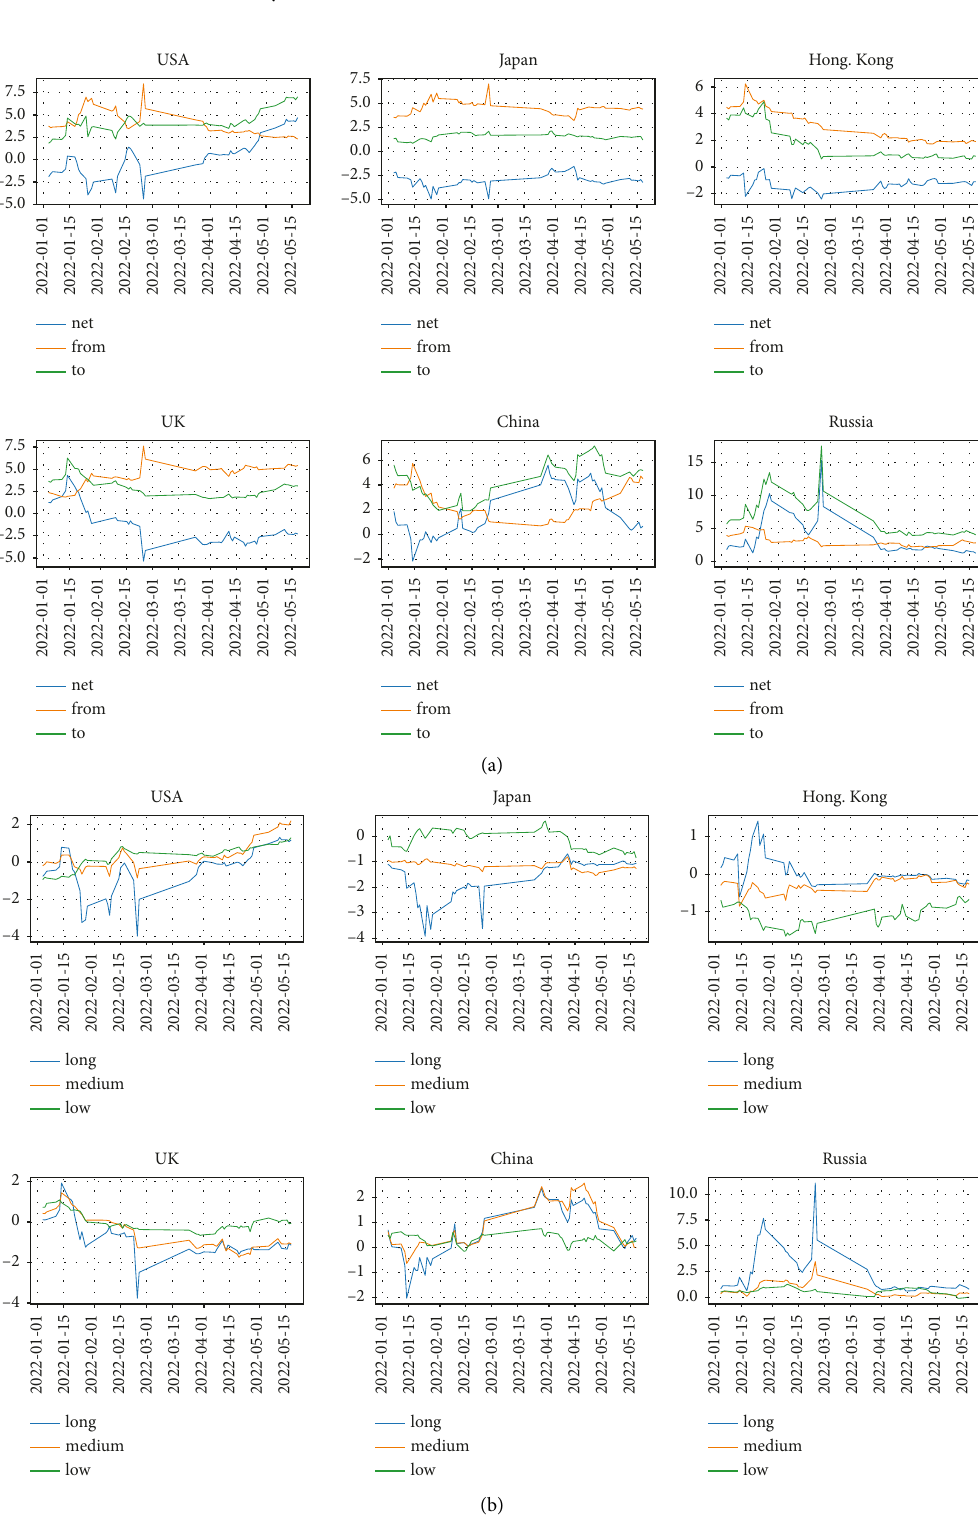
Figure 2: Directional spillovers and frequency decomposition. (a) Directional spillovers. (b) Time and frequency decomposition of di- rectional